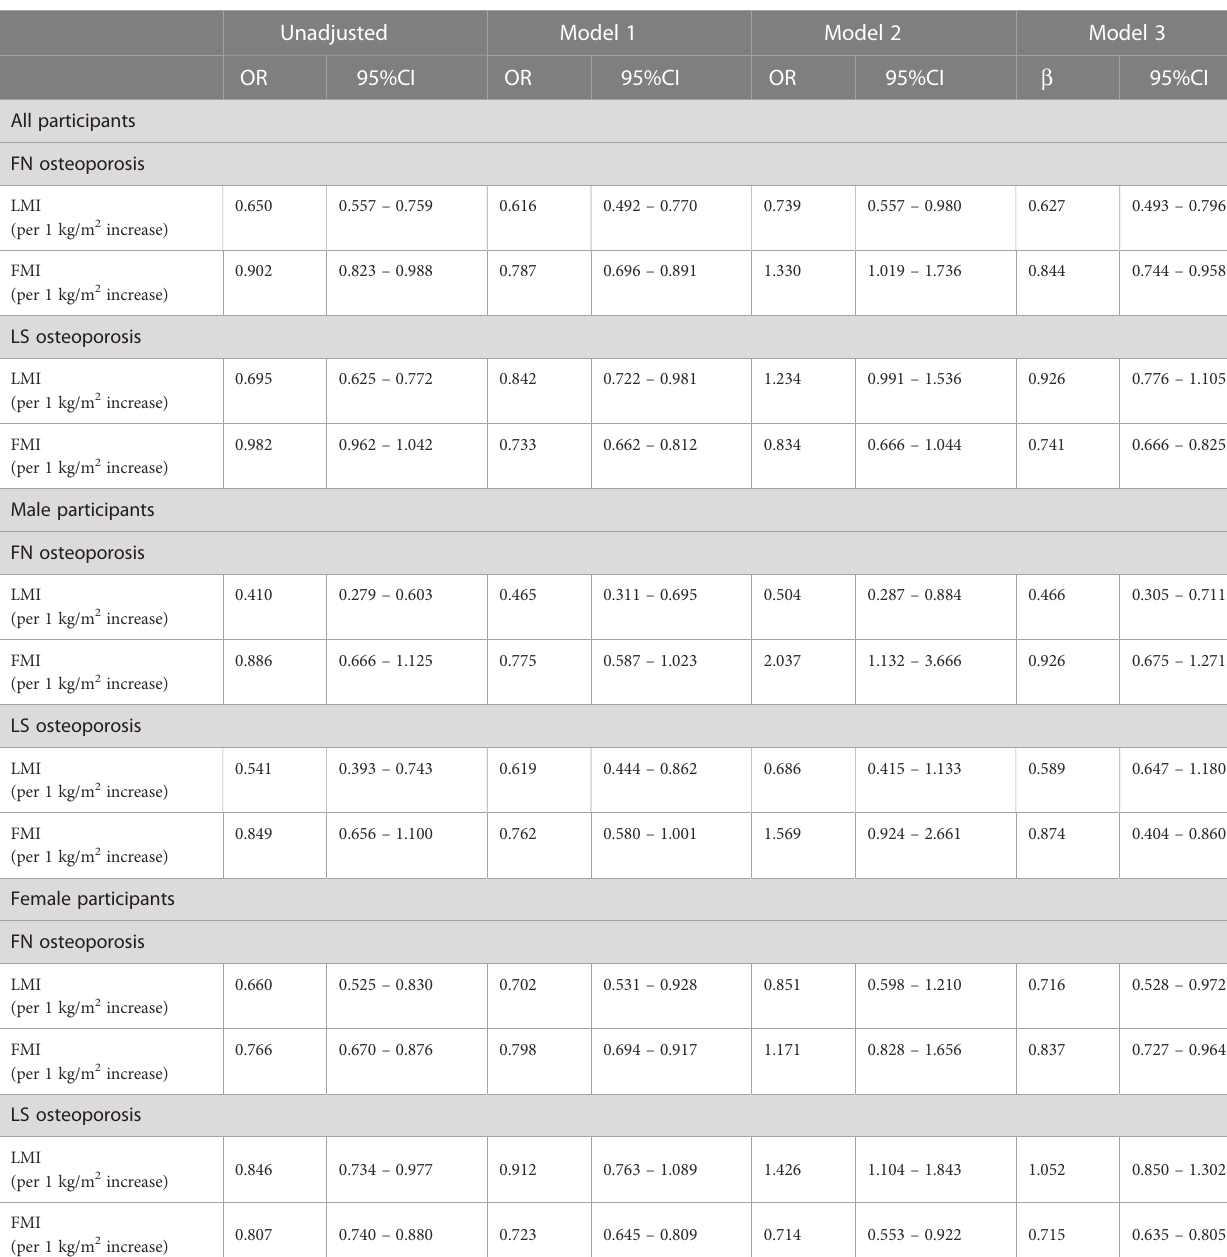
TABLE 3 Association of lean mass index and fat mass index with osteoporosis at femoral neck and lumbar